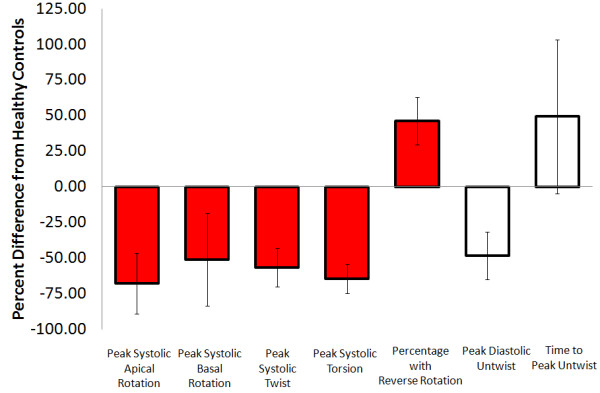
Dilated cardiomyopathy - Average percent difference in left ventricular peak systolic apical rotation (Range: Control; 5.4 to 15.8, Patients; 0.1 to 5.9 degrees),[7,30,34,36,58-61] peak systolic basal rotation (Range: Control; -2.6 to −7.1, Patients; -3.2 to −6.6 degrees),[7,30,34,36,58-61] peak systolic twist (Range: Control; 9.8 to 17, Patients; 4 to 7.35 degrees),[7,34,36,58-61] peak systolic torsion (Range: Control; 1.7 to 3, Patients; 0.4 to 1.3 degrees/cm),[7,34] percentage with reverse rotation,[7,30,58] peak diastolic untwist (Range: Control; -86 to −113, Patients; -37 to −62 degrees) [34,35,59,60] and time to peak untwist [59,60] between those with dilated cardiomyopathy and healthy controls as reported in existing articles. Systolic parameters denoted by red filled boxes. Diastolic parameters denoted by empty boxes.